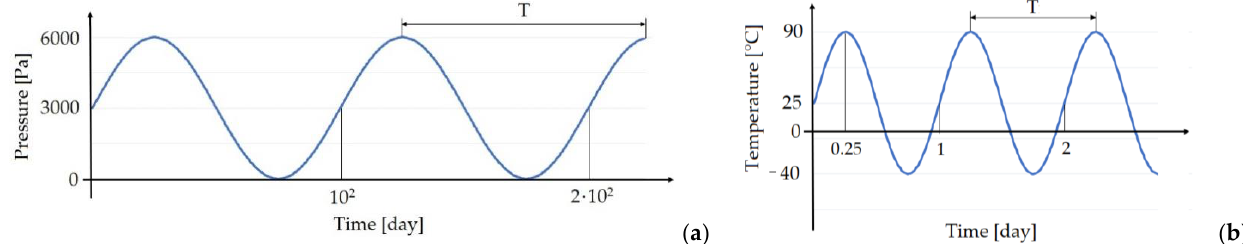
Figure 15. Mechanical ( a ) and thermal ( b ) cyclic stress applied on panels in TMF simulation. The dimension of 0.4 ± 0.1 for the thickness of standard PV cells (mono or polycrys- talline commercial PV cells) was taken as fixed data, and the thicknesses of each of the other layers, in order to guarantee longer durability with a similar layer stress, were evaluated. Factors of safety and total life cycles by equivalent von Mises stress are shown in Figure 16a and in Figure 16b, respectively. In both TMF simulations, the PV cell layer was found to be the most critical component. However, using a proper thickness (h s ) of the silicone rubber layer, it is possible to increase the safety factor by more than 40% (Figure 16c) and the total life cycle (Figure 16d) of the PV panel. The use of a silicone rubber layer also guarantees excellent impact resistance and the finest coupling and insulation conditions. In Table 7, highlighted in bold, the best values of geometric parameters that guarantee the greatest value of the total life are presented.